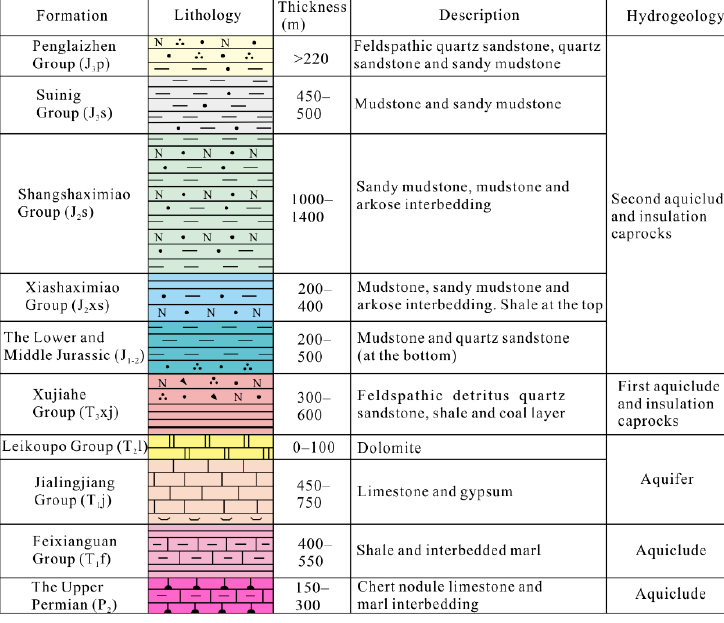
Figure 2. Stratigraphic column of the formations that outcropping formations in the study area.